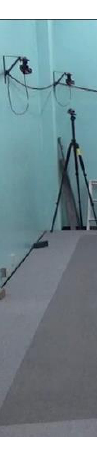
Figure 7. The elderly tester.